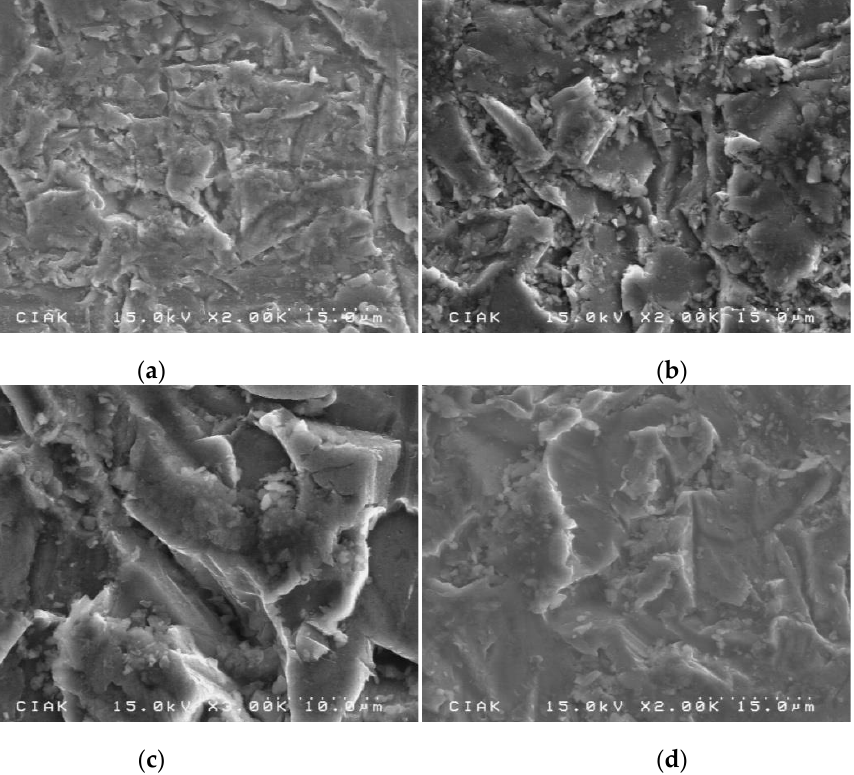
Figure 6. SEM micrographs of surface roughness increasing according to pressure increasing, ( a )